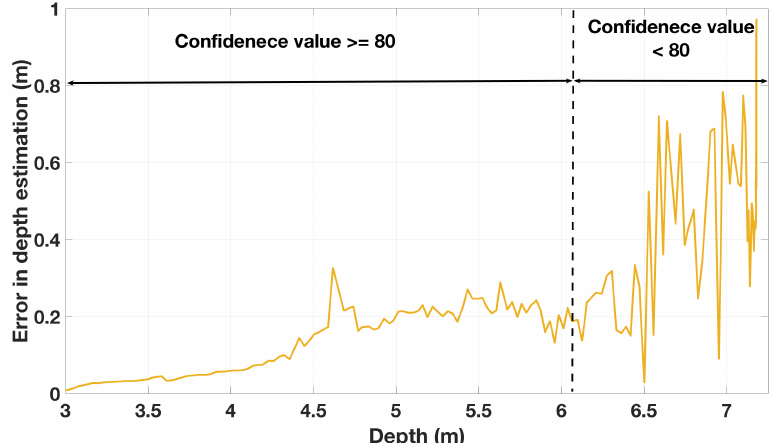
Figure 12. Estimation error using stereo camera.